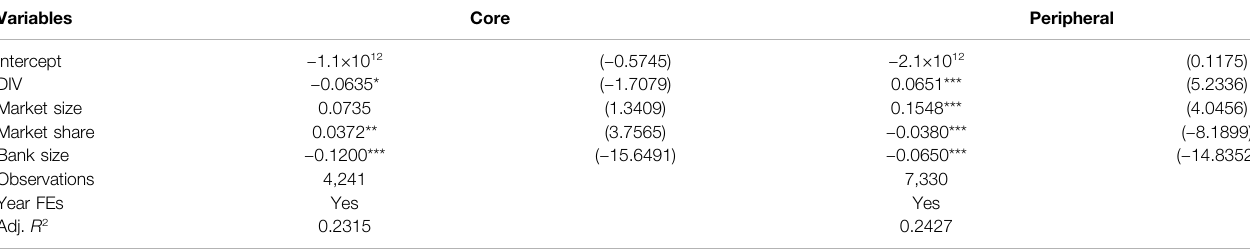
Weinvestigatetheeffectofdiversi fi cationonROAfor(1)thecoreofbanksand(2)peripheralofbanks.ROAisde fi nedasnetincomedividedbytotalassets.Diversi fi cation(DIV)ismeasured by the Shannon entropy of bank portfolio calculated as the amount of loans extended to ten industries by each bank. The control variable is consistent with Eq. 3 . Year fi xed effects are included to account for time characteristics. The t-statistic is reported in brackets. The symbols *, **, and *** indicate statistical signi fi cance at 10%, 5%, and, 1%, respectively.